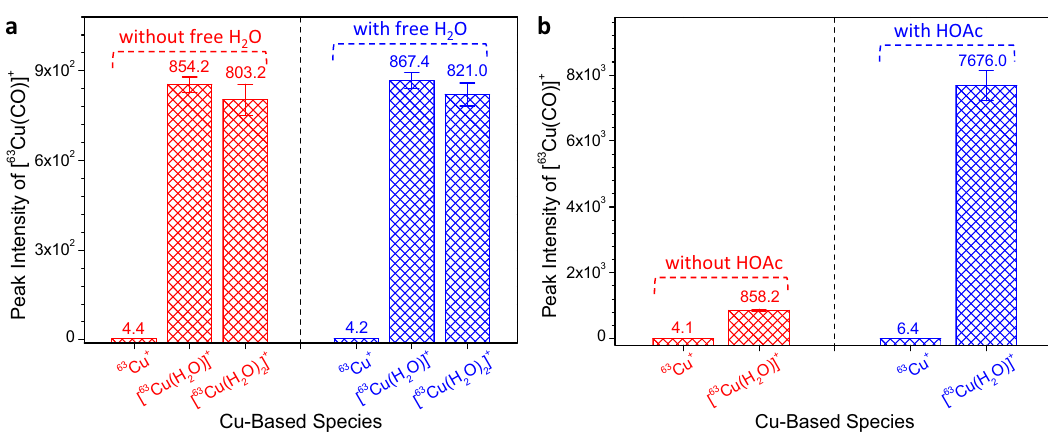
Fig. 5 In fl uence of the number of coordinated H 2 O, free H 2 O, and extraneous acid on the generation of CO. a Effects of the number of coordinated H 2 O and free H 2 O on CO 2 reduction to CO under different Cu-based catalytic systems ( 63 Cu + , [ 63 Cu(H 2 O)] + , and [ 63 Cu(H 2 O) 2 ] + ). b Effect of extraneous acid on the reduction of CO 2 to CO under different Cu-based catalytic systems. Note: The free H 2 O and HOAc (acetic acid) were injected into the gas circuit system by an injector; gas circuit temperature: 280 o C; reaction pressure: 1.5 mTorr; n =